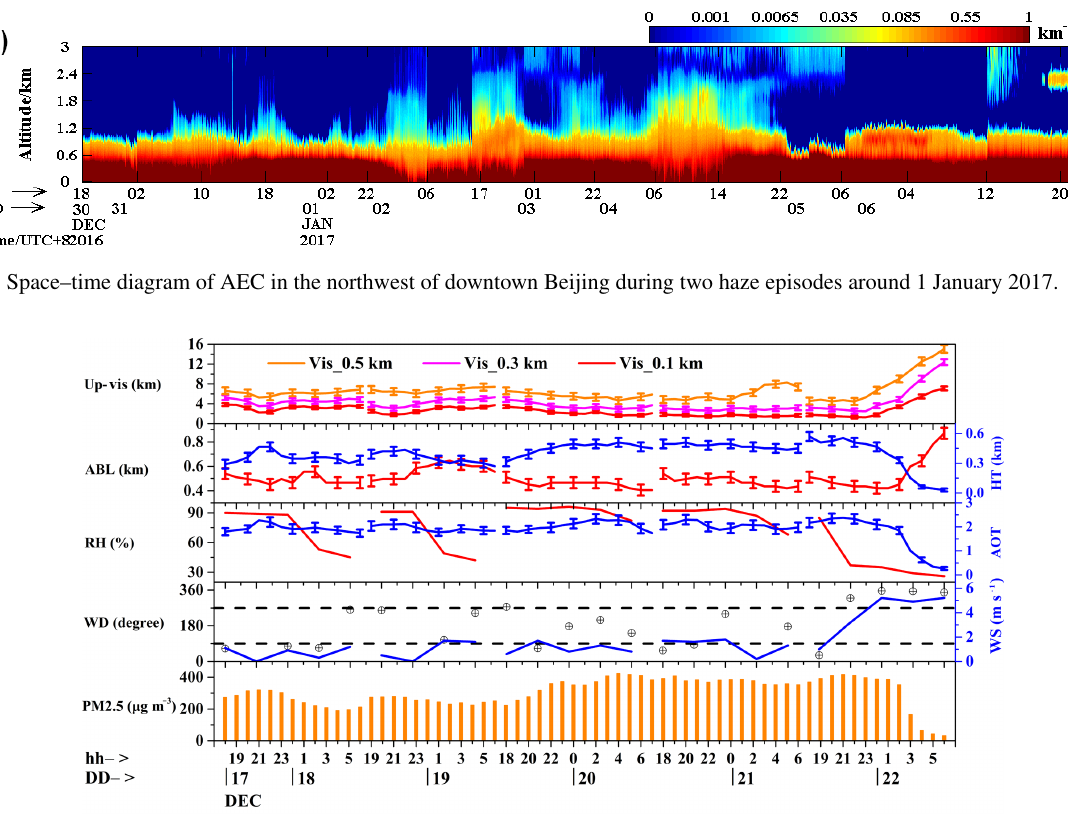
22 December 2016. The error bars indicate data